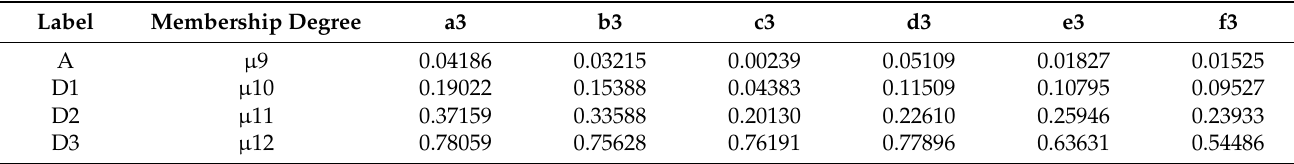
Table 14. Fuzzy set of leakage faults in the hydraulic